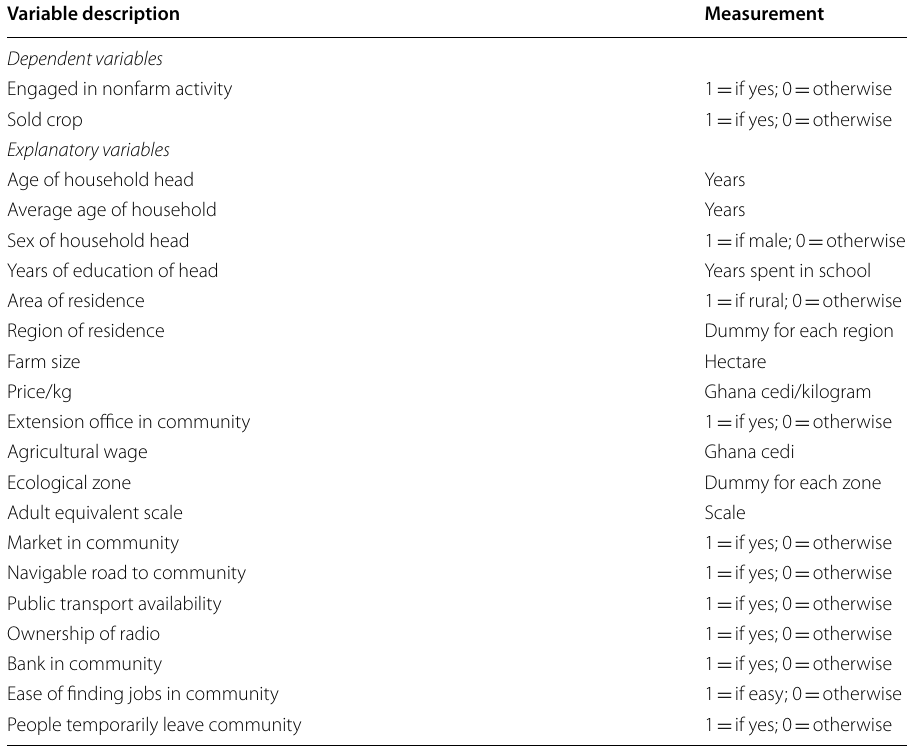
a Represents aggregate variables for the five crops: maize, rice, groundnut, beans, and sorghum; price/kg is calculated as the average of the price/kg for each crop